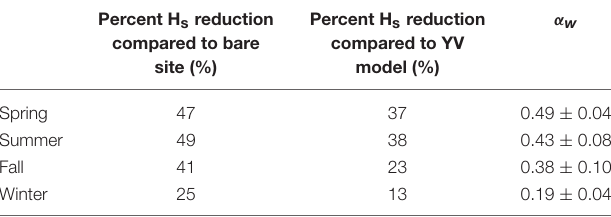
TABLE 4 | Summary of average attenuation statistics.